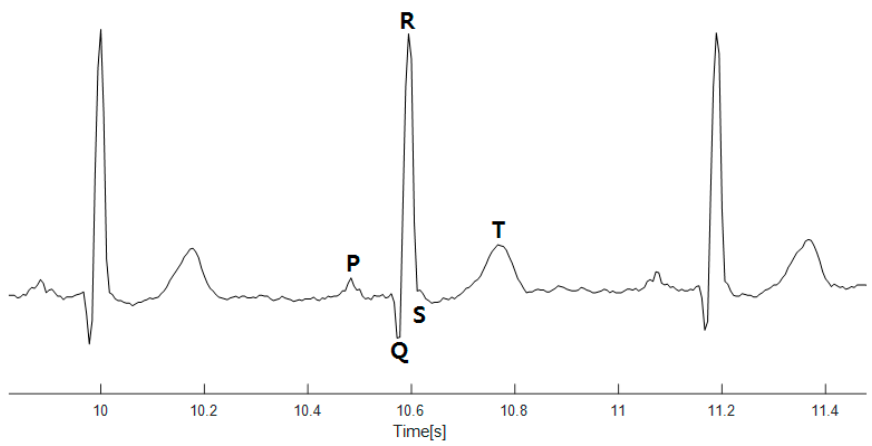
Figure 1. Basic ECG signal cycle.